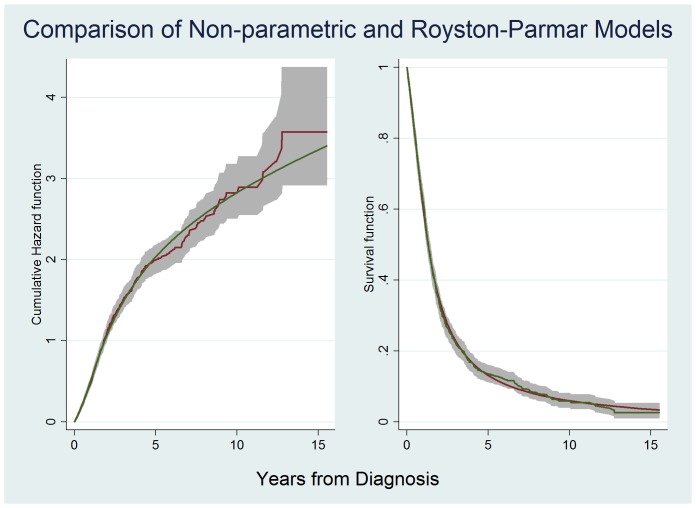
Cumulative Hazard function and Survival function of Non-parametric and Royston-Parmar models.The graph on the left shows cumulative hazards estimated using the Nelson-Aalen method (red line) with 95% CI’s (grey area) and the cumulative hazard estimated by Royston-Parmar PH (df 3) modeling (green line). The graph on the right shows the survival function estimated using the Kaplan-Meier method with 95% CI’s (grey area) and the survival function estimated by Royston-Parmar PH (df 3) modeling (green line). These graphs were based on the full cohort minus those missing data for key variables (n = 1086). As can be seen the Royston-Parmar models provides excellent fit when compared to non-parametric methods.